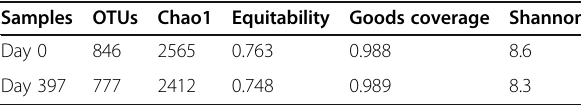
Table 1 Diversity indices calculated from sequences of 16S rRNA genes recovered from day 0 and 397